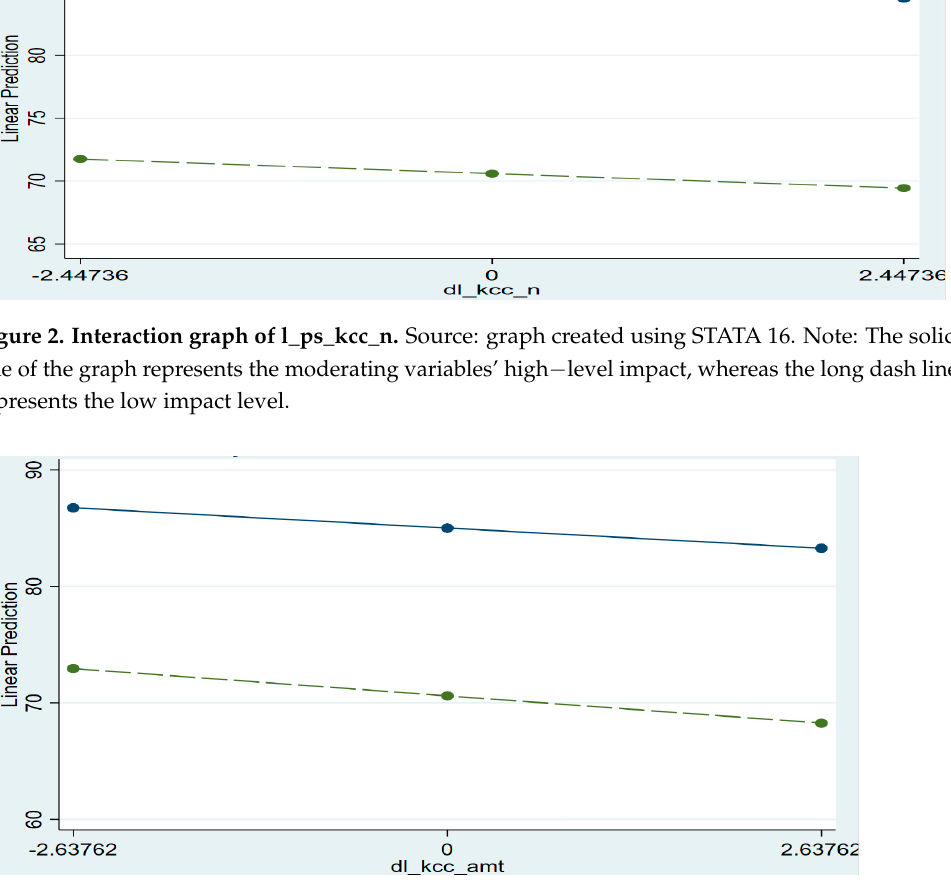
Figure 3. Interaction graph of l_ps_kcc_amt. Source: graph created using STATA 16. Note: The solid line of the graph represents the high impact of the moderating variables, whereas the long dash line represents the low impact level.